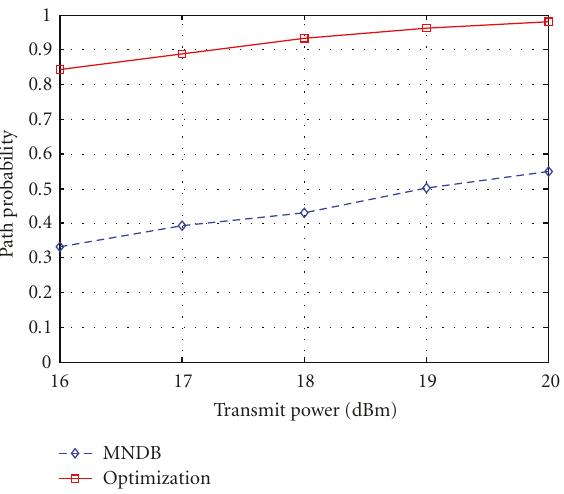
Figure 7: Path probability optimization versus MNDB.